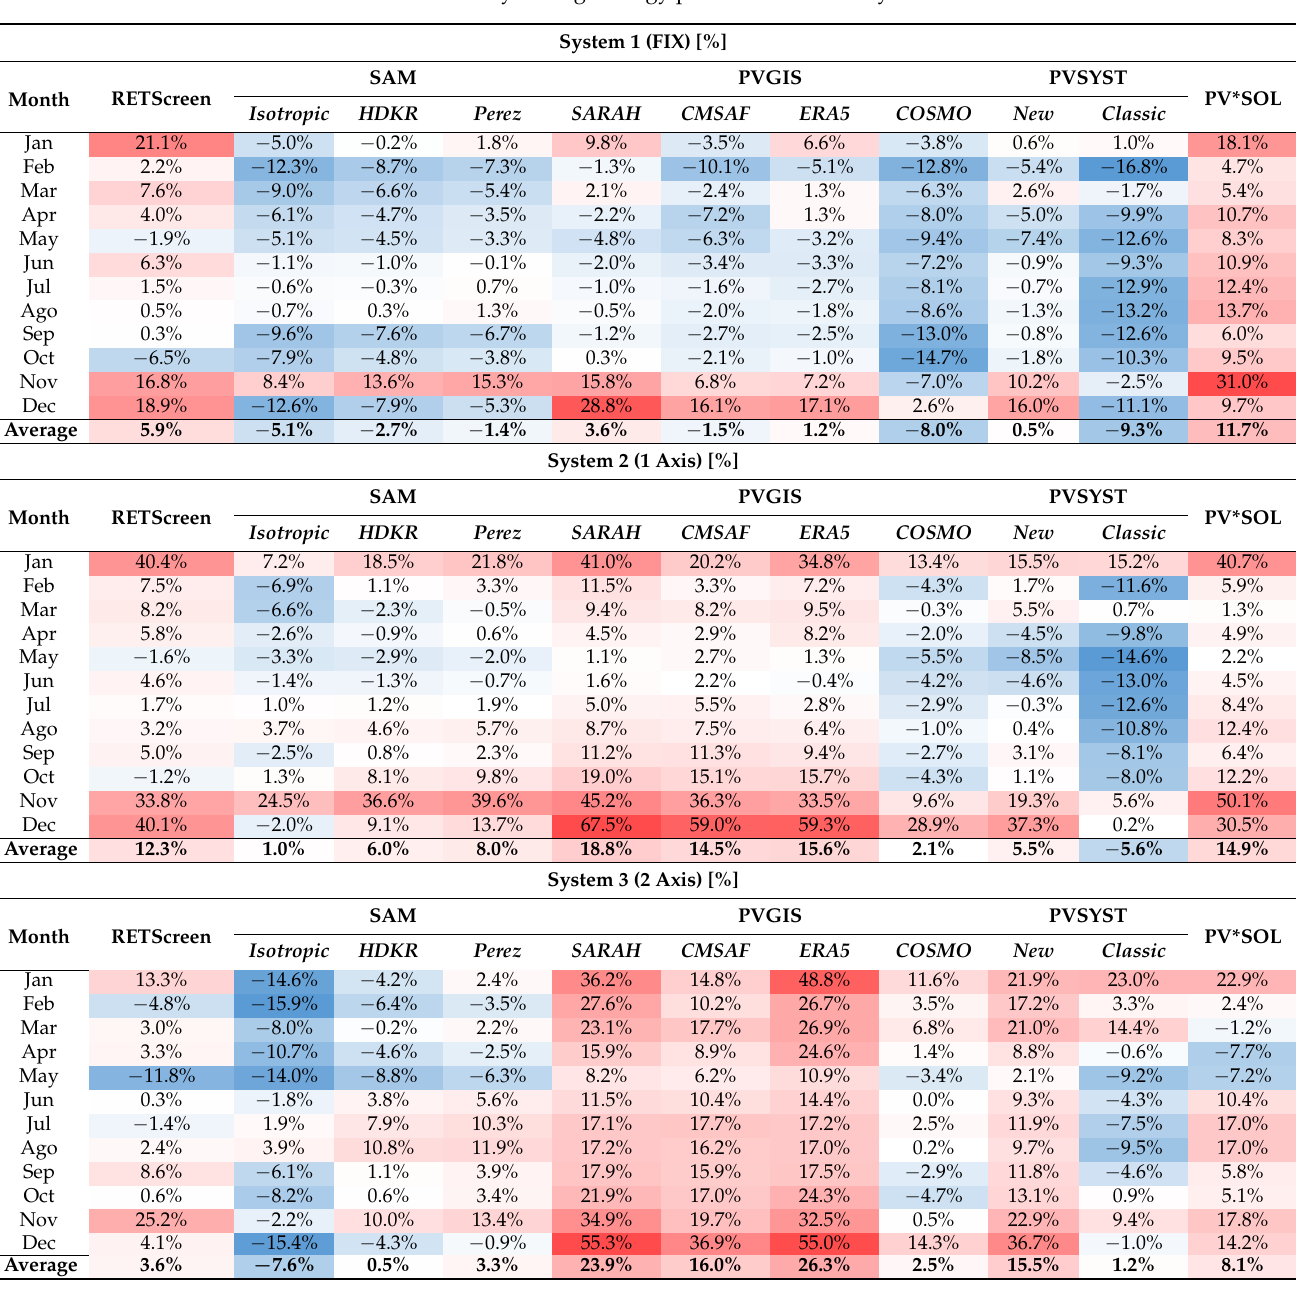
Table 5. Monthly average energy production of each